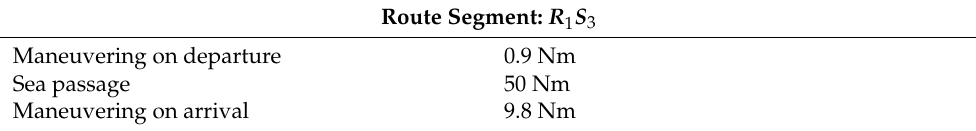
Figure 5. Route segment R 1 S 3 : ( a ) maritime transportation; ( b ) road transportation. Table 8. Distances traveled in the specific navigation mode on the route segment R 1 S 3